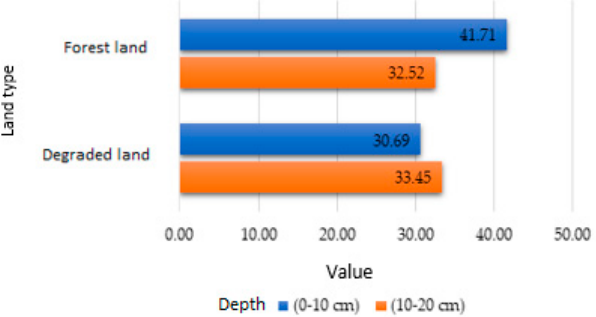
Figure 7. The average carbon sequestration depending on the type of land use.